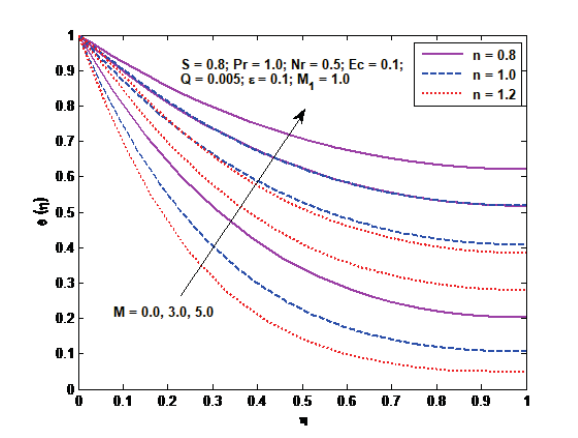
Fig. 9: Temperature profiles for different values of S